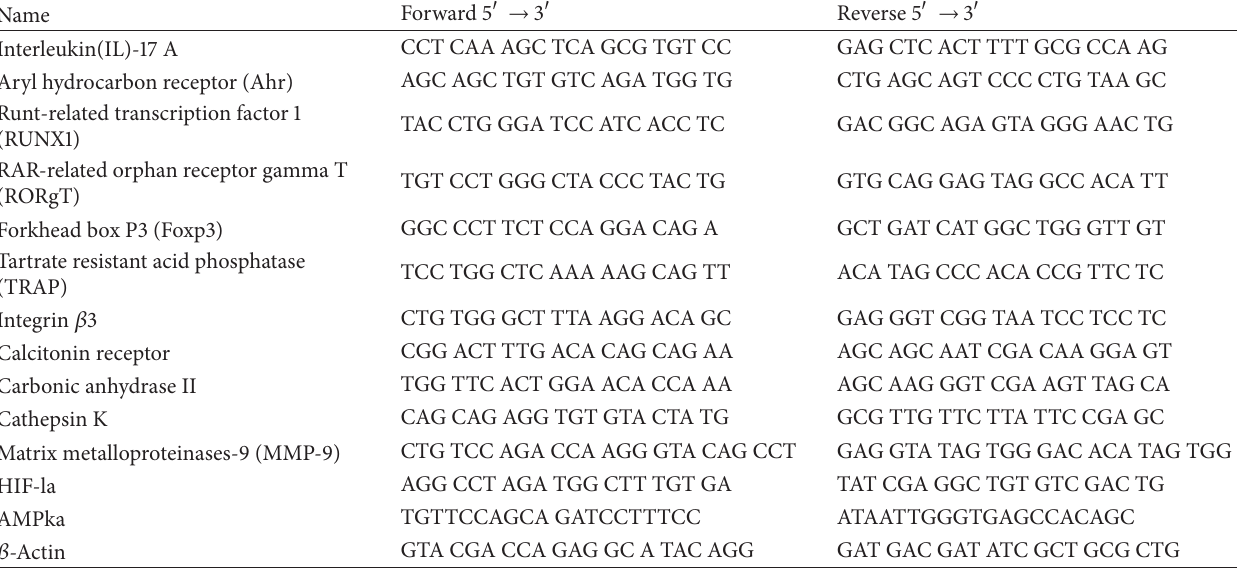
Table 1: Mouse primer